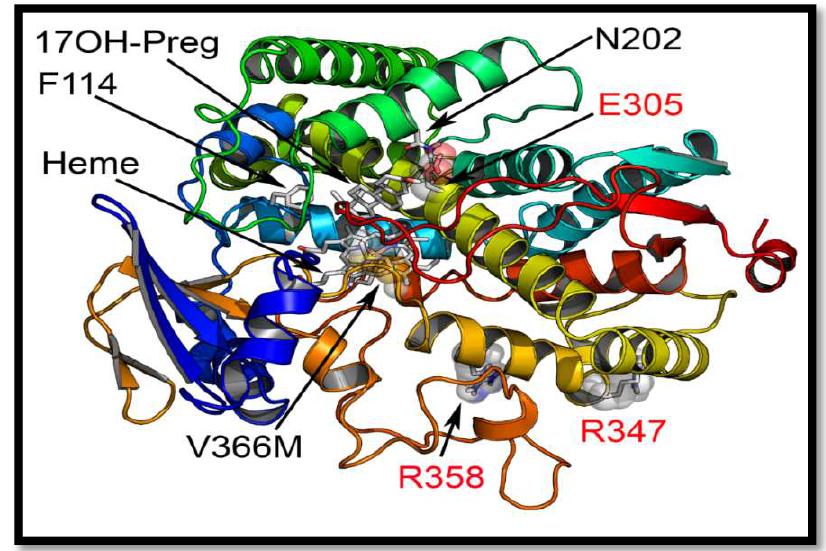
Figure 6. Comparison of novel V366M mutation with the previously reported isolated CYP17A1-17,20 lyase mutations. Only three other residues in CYP17A1 have been reported to be mutated in patients with isolated 17,20 lyase deficiency. The R347 and R358 are at the redox partner binding sites and their mutations may interfere with binding of POR and /or cytochrome b 5 . The E305 residue at the active site is important for orientation of the substrate and its mutation has been shown to alter substrate specificity and lead to a preference for progesterone as the more efficient substrate. The V366 is located exactly at the active site of the CYP17A1.